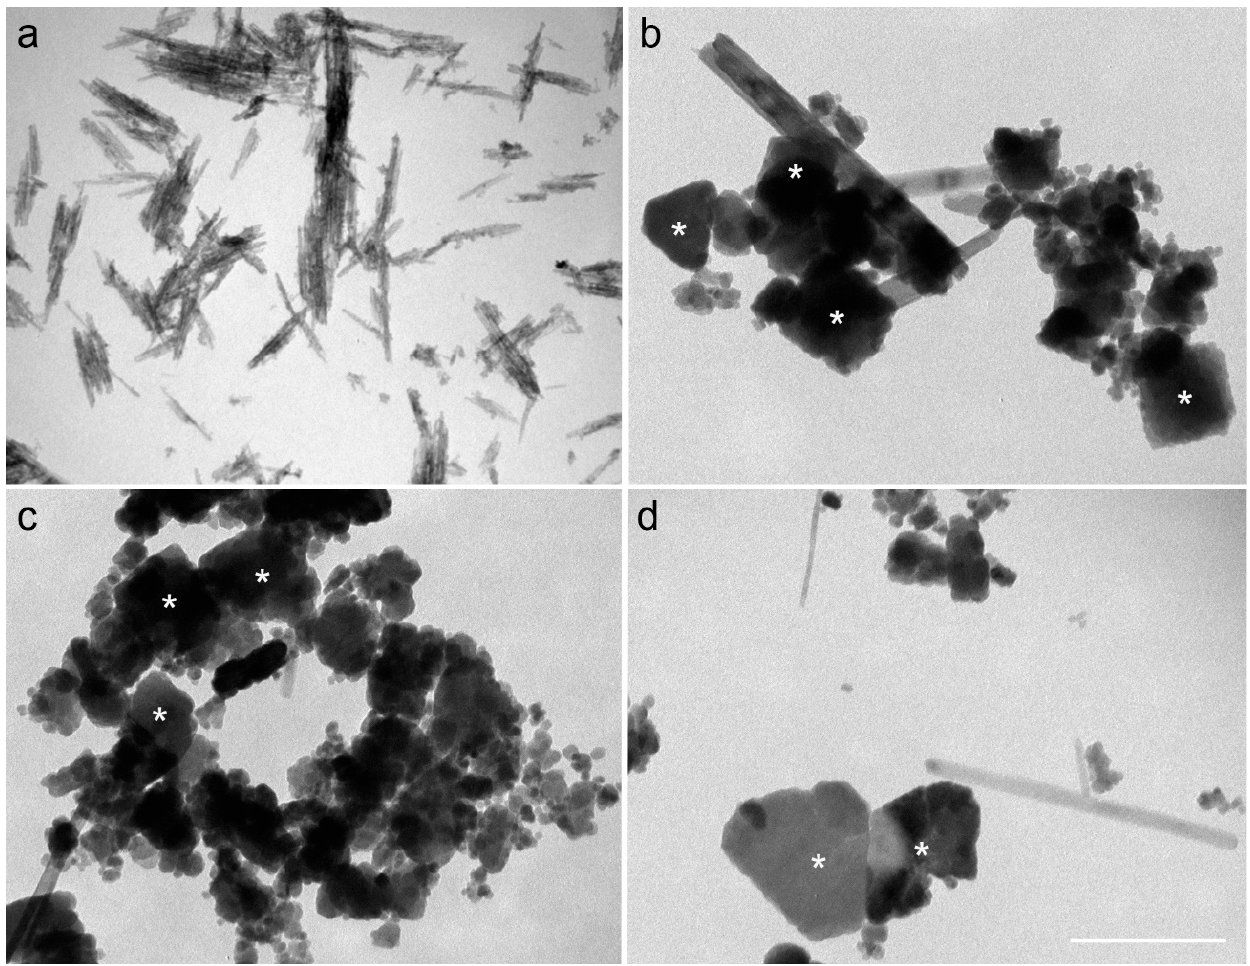
Figure 6. Transmission electron micrographs of the solid phase of enrichment cultures using the synthetic Fe(III) source, showing the evolution of mineral morphologies after 170 days. ( a ) Sample from control (autoclaved) cultures, showing the predominance of elongated nanoparticles. ( b – d ) Samples of the black magnetic material that developed in half of the living cultures, showing larger particles, some with octahedral morphologies compatible with magnetite (asterisks). Elongated, lath-shaped crystals were less common than octahedra and other equidimensional particles. ( b ) GNR-M-B, ( c ) GNR-M-C, and ( d ) GNR-BL-A. For more details on samples, see Table 1. Scale bar = 200 nm. Table 3. Size and shape factor of crystalline particles observed by transmission electron microscopy.